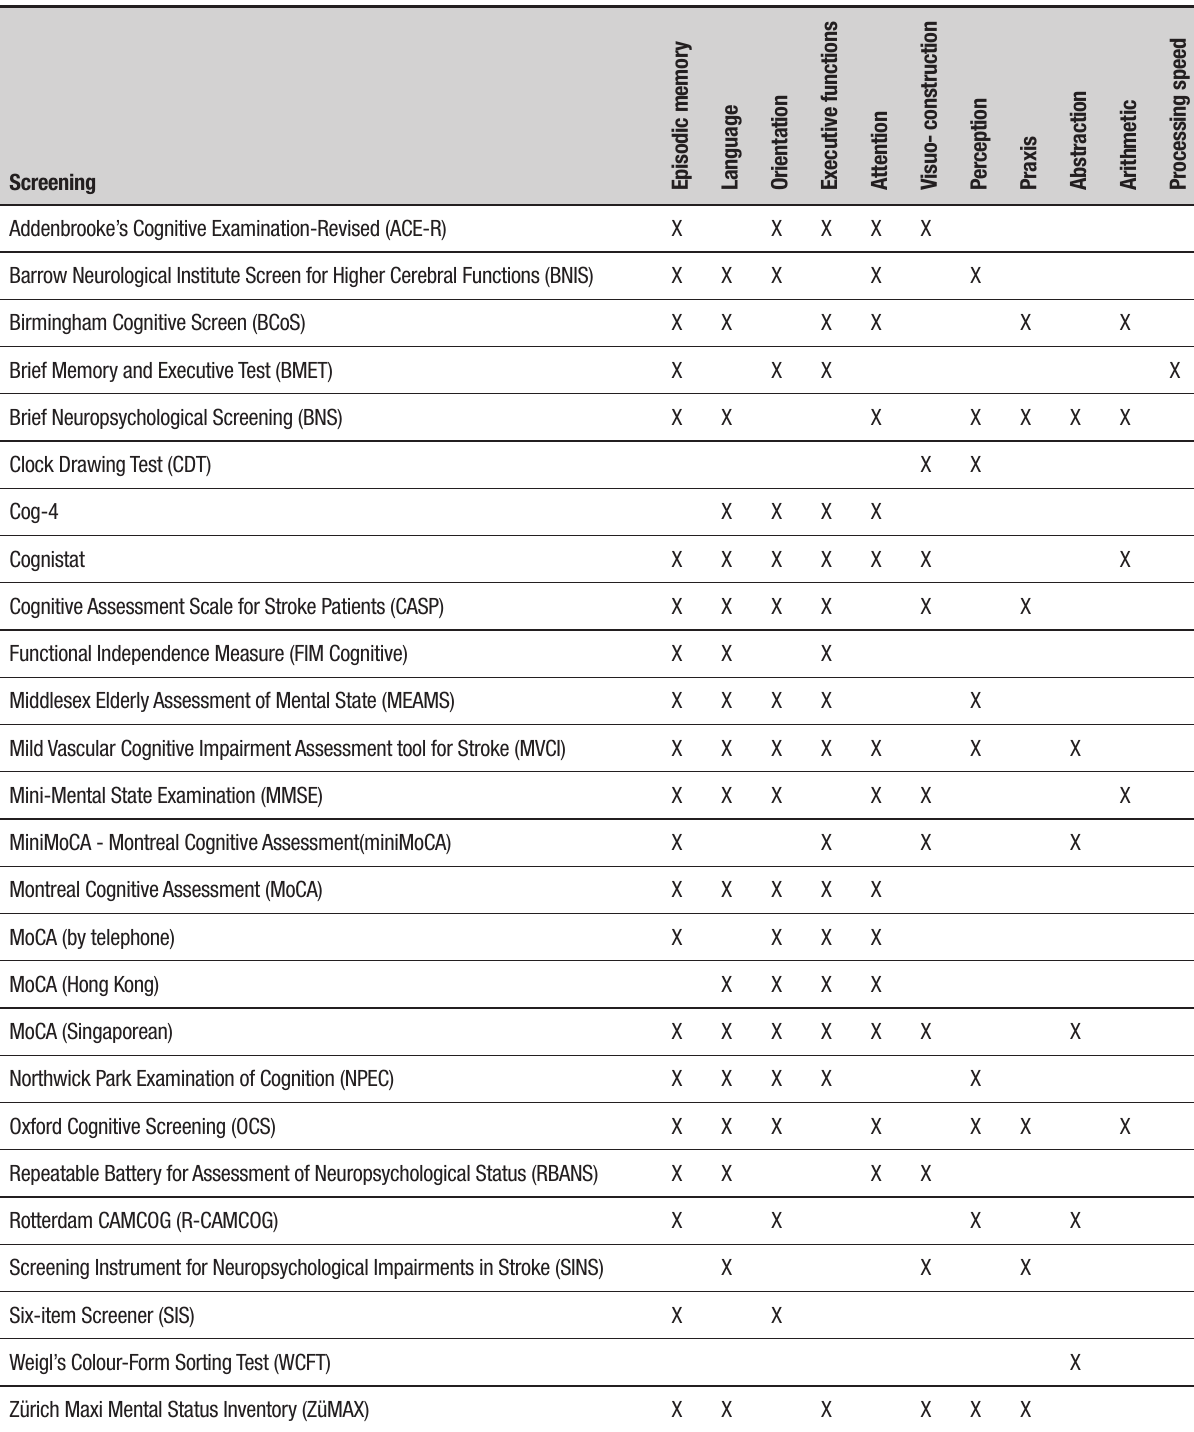
Table 3. Neuropsychological screening and functions evaluated.